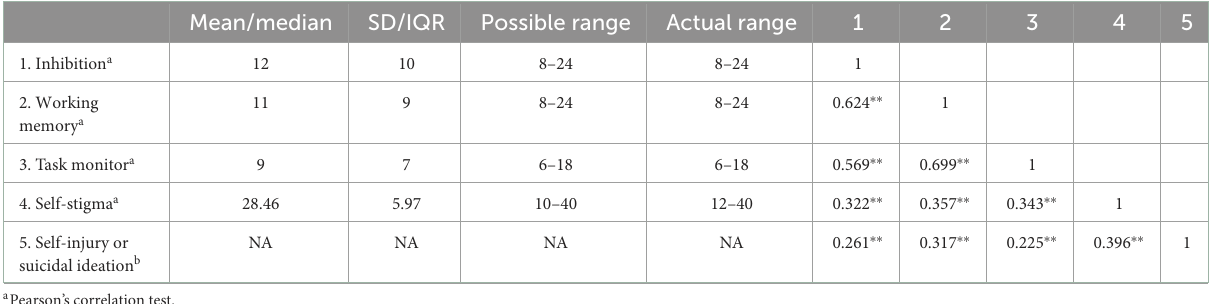
TABLE 2 Correlations for the relationships between executive function (inhibition, working memory, task monitor), self-stigma, and self-injury or suicidal ideation. Mean/median SD/IQR Possible range Actual range